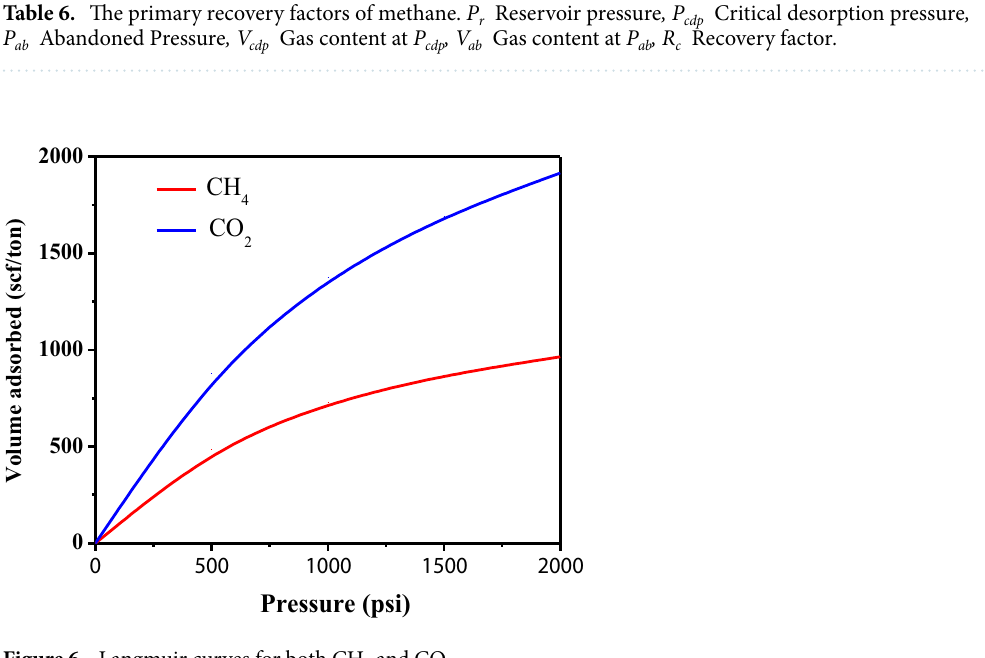
Figure 6. Langmuir curves for both CH 4 and CO 2 .